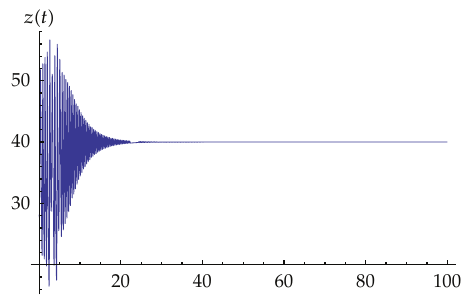
Figure 10: Controlled signal α (cid:8) 0 . 98 (cid:3) k (cid:8) 15 (cid:4) .